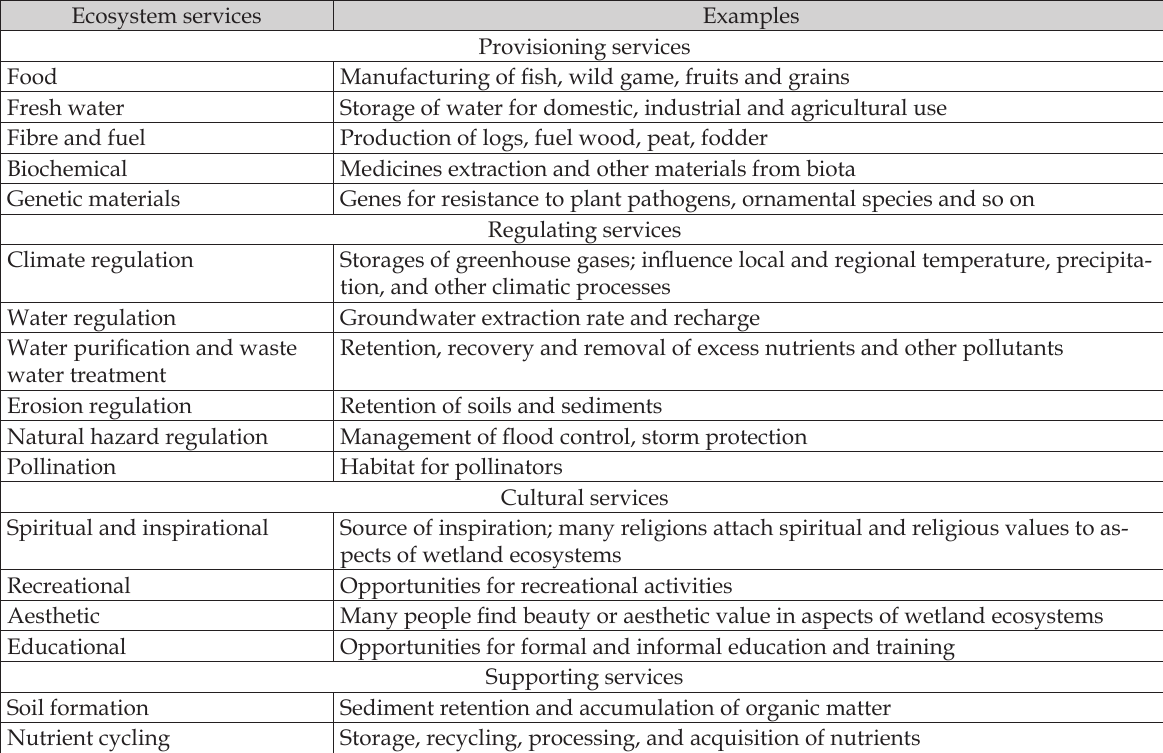
Table 1. Different types of ecosystem services provided by